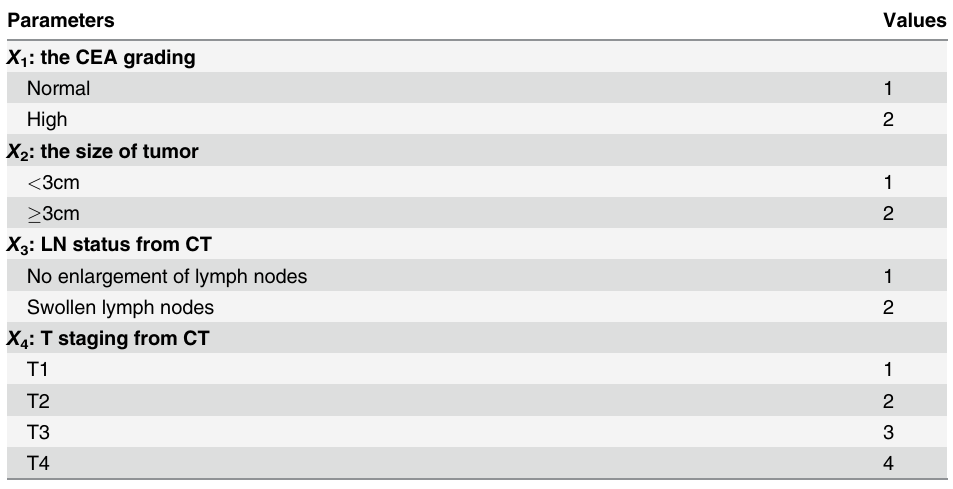
Table 6. The values of all parameters of the unstandardized canonical equation. Parameters Values